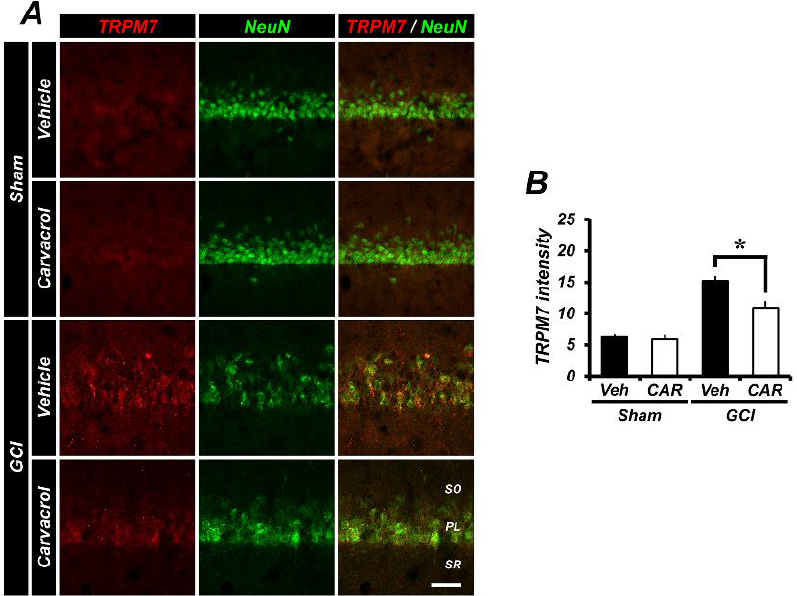
Figure 4. The transient receptor potential melastatin 7 (TRPM7) channel expression level was verified by performing TRPM7 staining and counter-staining with neuronal nuclei. ( A ) In the sham group, the TRPM7 channel expression level showed baseline intensity. This red TRPM7 fluorescence signal was increased in the ischemia vehicle group. Carvacrol administration after GCI for three days showed a neuroprotection effect in the hippocampal CA1 region via inhibition of the TRPM7 channel. Scale bar = 50 μm. ( B ) Quantified TRPM7 channel intensity (red color) in CA1 (sham vehicle: n = 5; sham carvacrol: n = 4; GCI vehicle: n = 5; GCI carvacrol: n = 5). Data are the mean ± SEM, * p < 0.01.